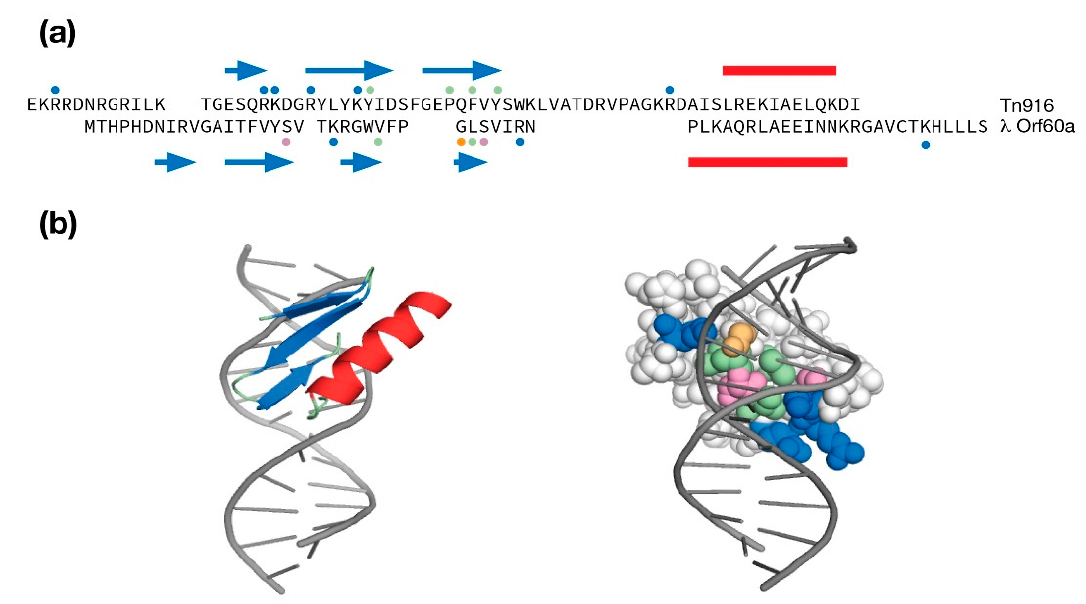
Figure 4. Modeling λ Orf60a as a potential DNA binding domain. ( a ) Structure based sequence alignment of λ Orf60a and the Tn916 DNA binding domain. An α -helix is indicated by a red bar, a β -strand is indicated as a blue arrow. Dots above and below the sequence indicate amino acids that make DNA contacts in the Tn916 NMR solution structure (PDB:1B69) or are predicted to make DNA contacts in the λ Orf60a model (pink = polar, green = aliphatic/aromatic, blue = basic). ( b ) The RoseTTAfold λ Orf60a model was docked onto DNA and refined to remove steric clashes. The space-filled protein is colored according to the legend below the λ Orf60a sequence.